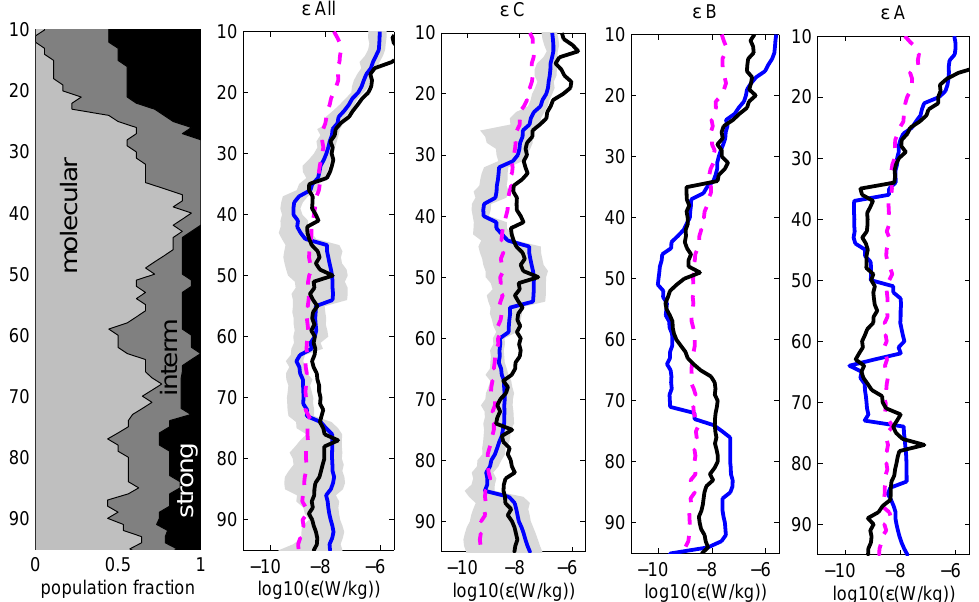
44 Fig. 8. Panel 1: proportion of the various diffusion regimes (strong, intermediate, molecular) found from SCAMP dissipation rate measurements. Panel 2, 3, 4, 5: overall and station averaged profiles of dissipation rate from SCAMP in blue plain line with 95% confidence intervals in gray shading, parameterization in black, and reference GM level in magenta dashed lines